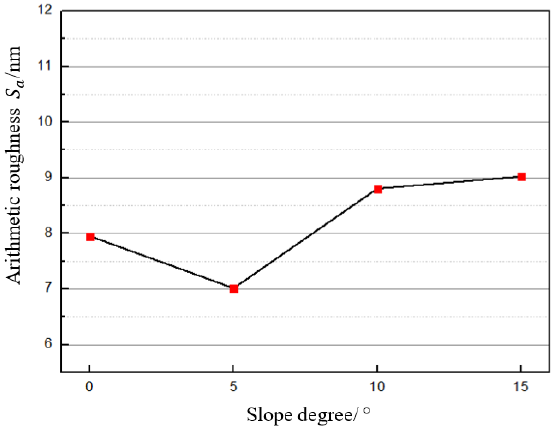
Figure 8. Arithmetic roughness S a with respect to various slope